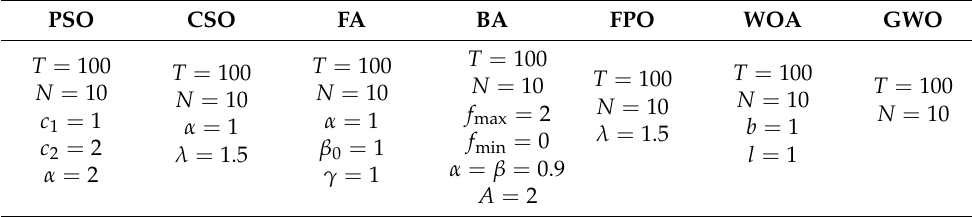
Table 1. Parameters for each